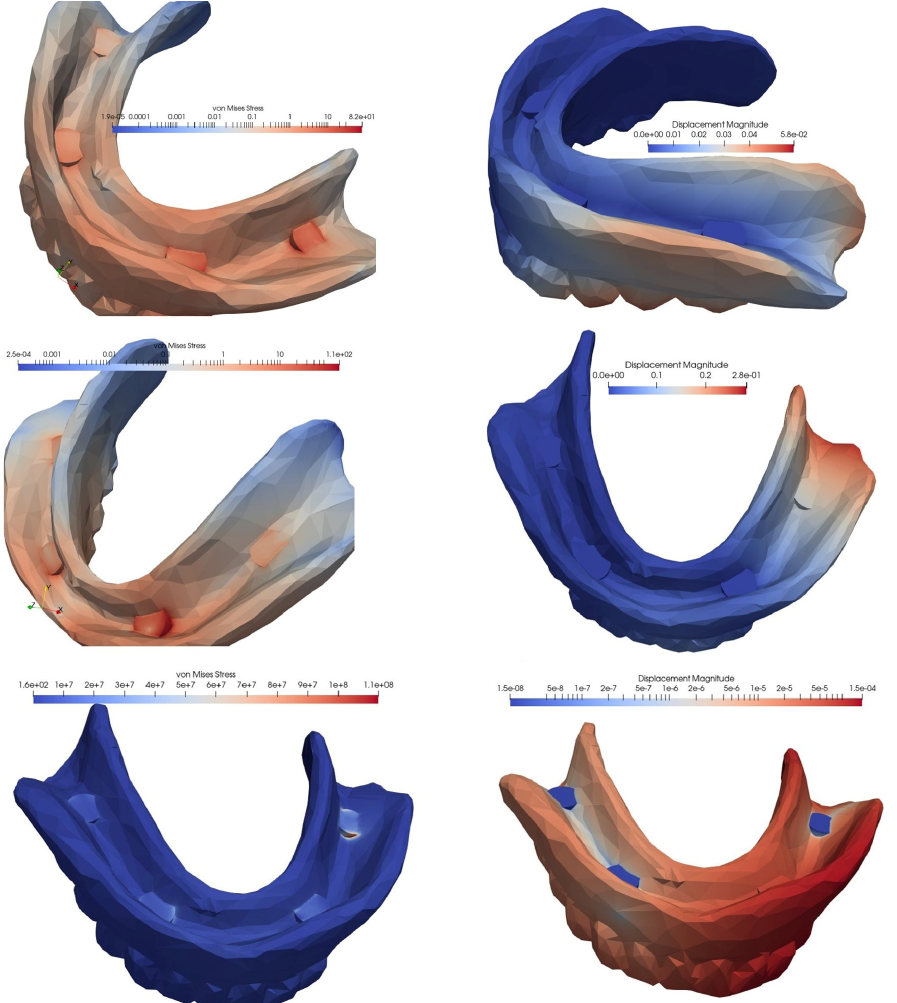
Figure 10. The von Mises stresses and displacements generated by the unilateral loading of an over- denture on four MDIs, two of which are inserted in the canine area and two in the molar area ( top ), compared to the situations of loss of an implant in the molar area ( middle ) or the canine area ( bottom ).